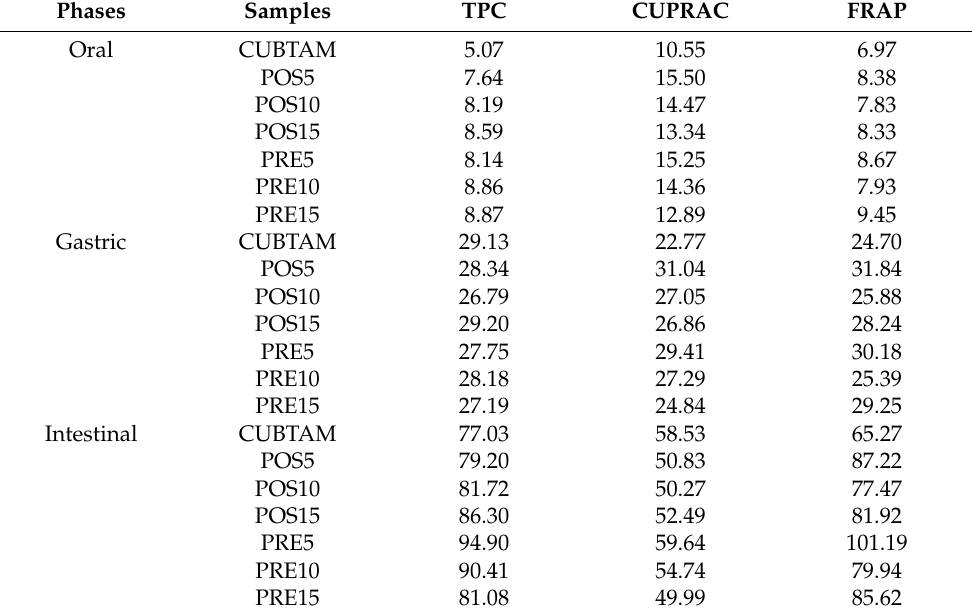
Table 3. Measures of total phenolic content and antioxidant activity of supernatant of cubosome encapsulated tamarillo and yoghurt fortified with encapsulated tamarillo during in vitro digestion. Phases Samples TPC CUPRAC FRAP Oral